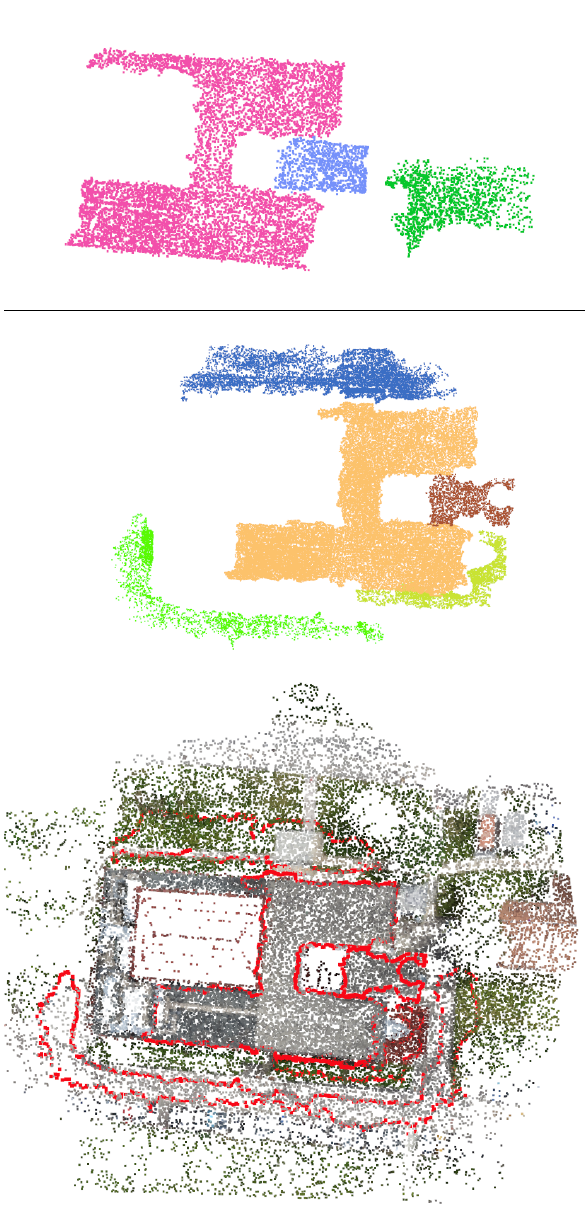
Figure 5. Parallel planar surfaces constituting the majority of the overlapping area (top and middle). The correction based on the plane’s contour points (bottom) produces an improvement over the alignment from fig. 3, in spite of dataset-specific